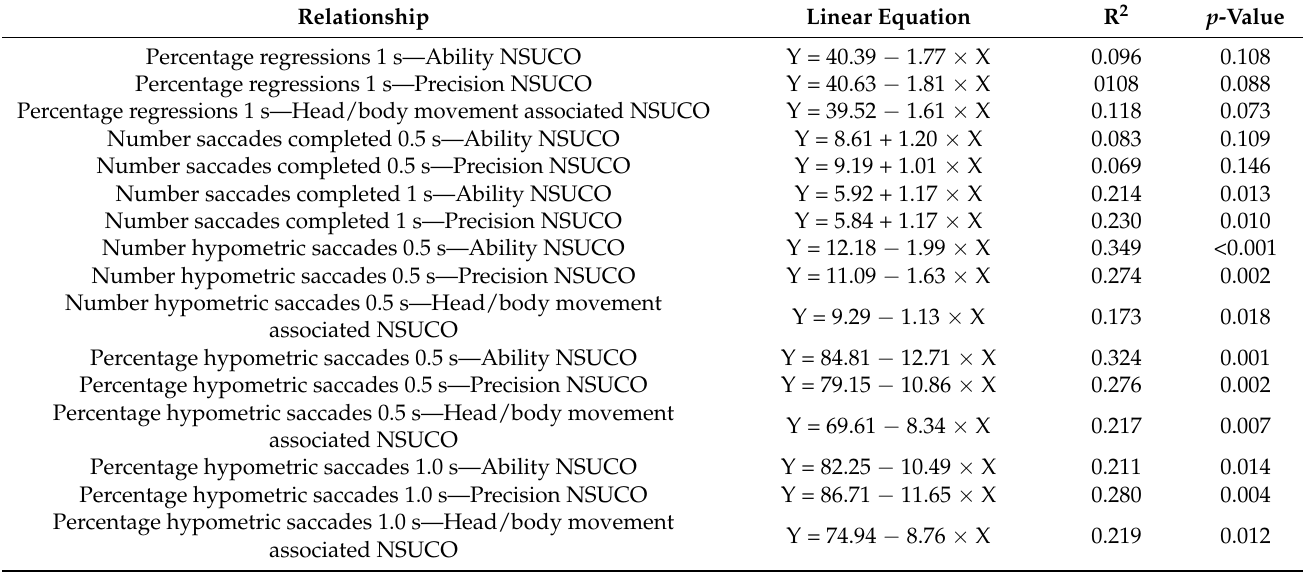
Table 4. Summary of the outcomes of the linear regression analysis for these relationships among subjective and objective oculomotor parameters showing statistically significant correlations in the whole sample (Y = objective parameter, X = subjective